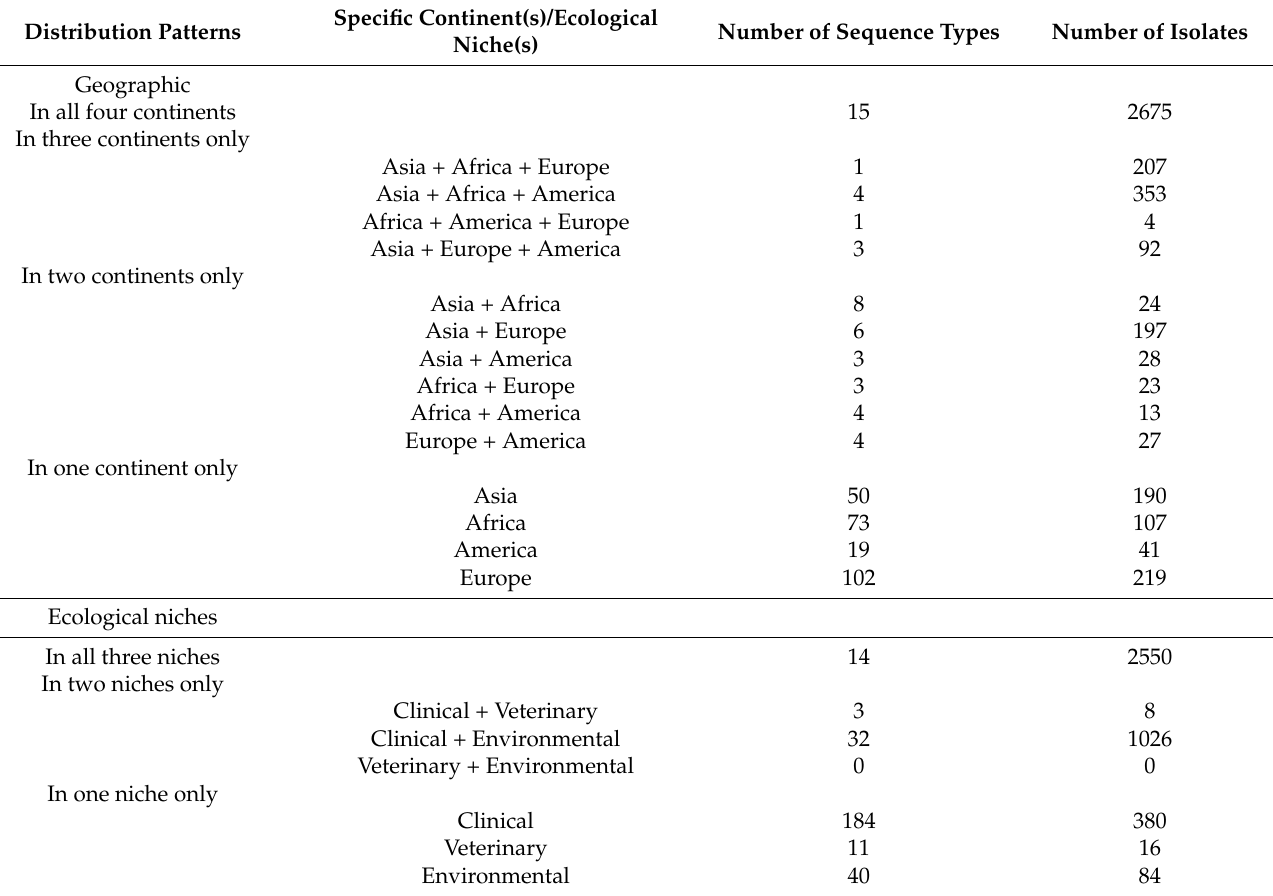
Table 2. Summary distribution of 296 sequence types of the C. neoformans species complex among continents and ecological